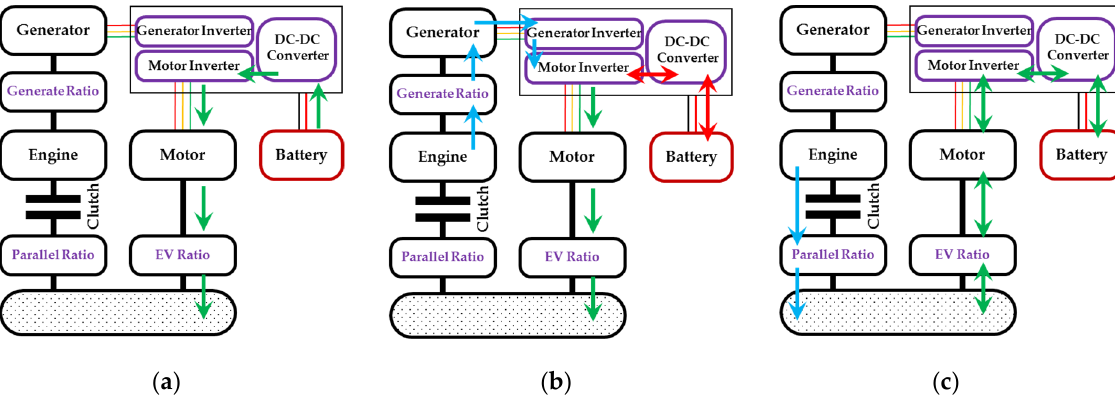
Figure 2. Powertrain operation: ( a ) Electric drive mode; ( b ) Series hybrid drive mode; and ( c ) Parallel hybrid drive mode.